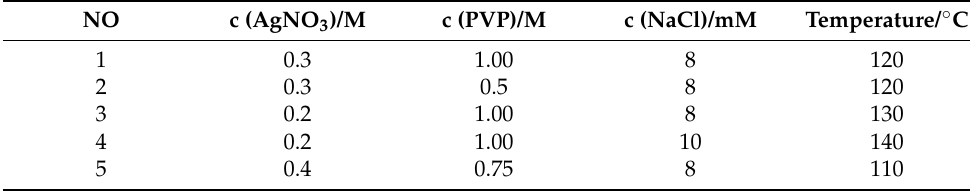
Table 1. Synthetic formulas of different sizes of silver